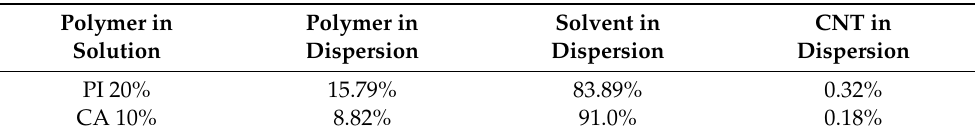
Table 1. Concentrations of polymer, solvent, and CNTs in dispersions prepared from polymer solutions and 1.5 wt.% CNT predispersion for membranes with a CNT concentration of 2 wt.% after